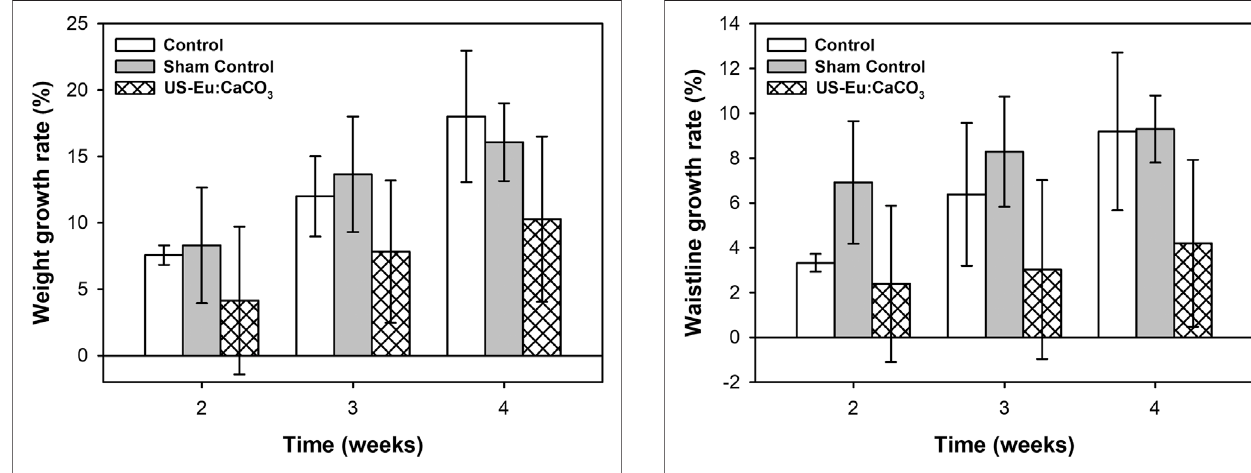
Figure 11 was the waistline measurement of the experiment rats.